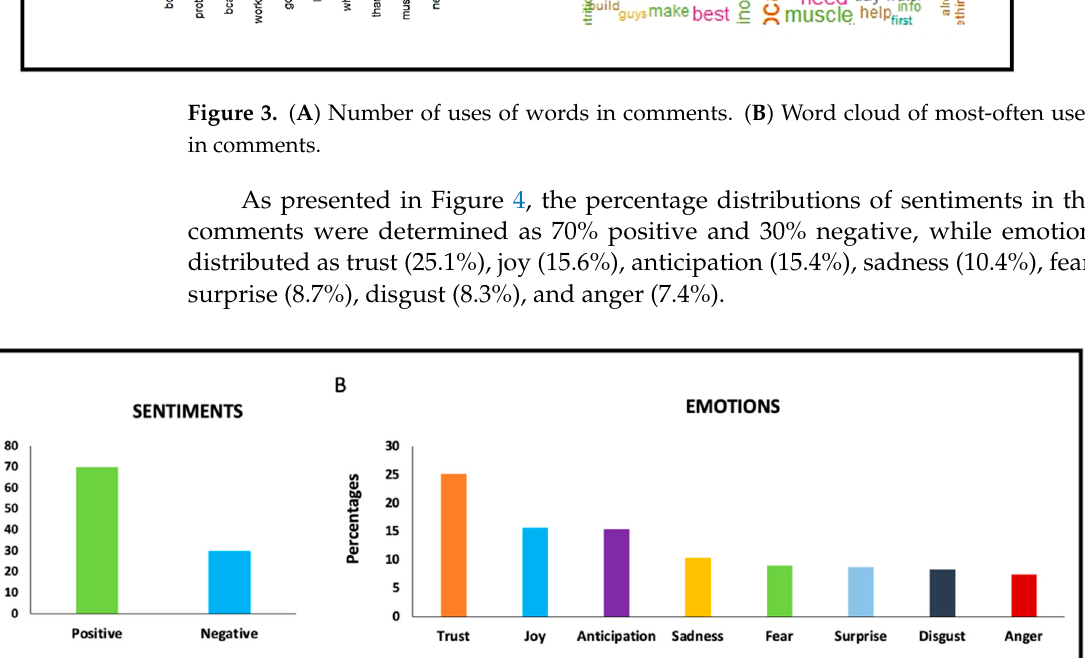
Table 3. Correlations between features of videos and sentiment–emotion scores with the DISCERN, JAMA, and GQS scoring systems.